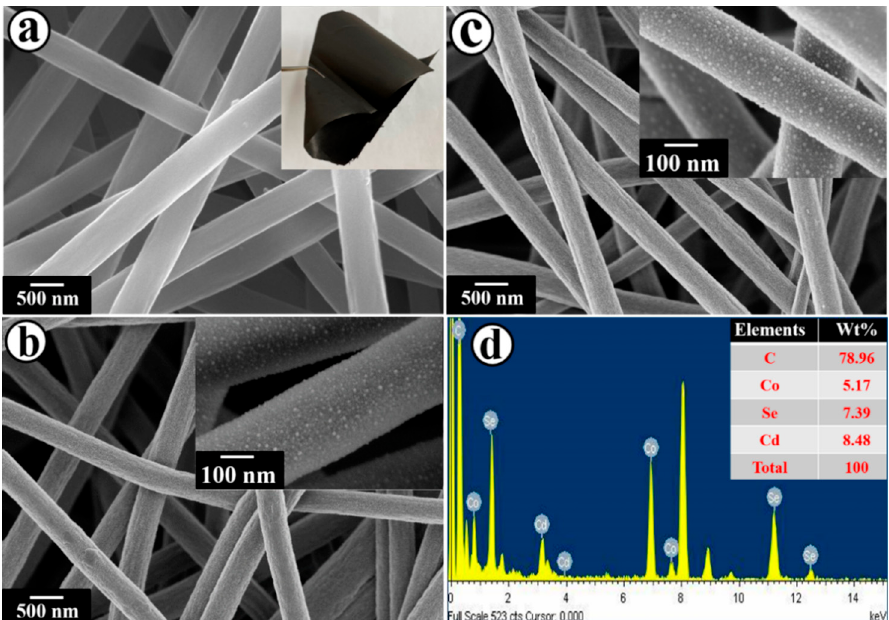
Figure 2. FESEM images: ( a ) ECNFs, ( b ) CdSe@ECNFs, and ( c ) Co-CdSe@ECNFs. Panel ( d ) represents the corresponding EDS of ( b ). Insets: ( a ) digital photograph of Co-CdSe@ECNFs, ( b , c ) high-magnification images of corresponding nanofibers, and ( d ) wt% of elements present in Co-CdSe@ECNFs.